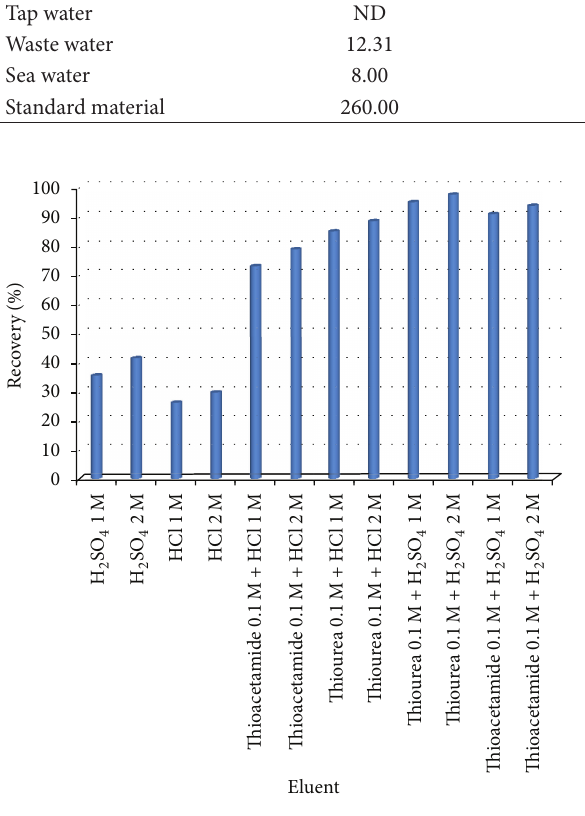
amounts of gold were spiked into the samples (Table 2). As shown, in all cases, the recovery is almost